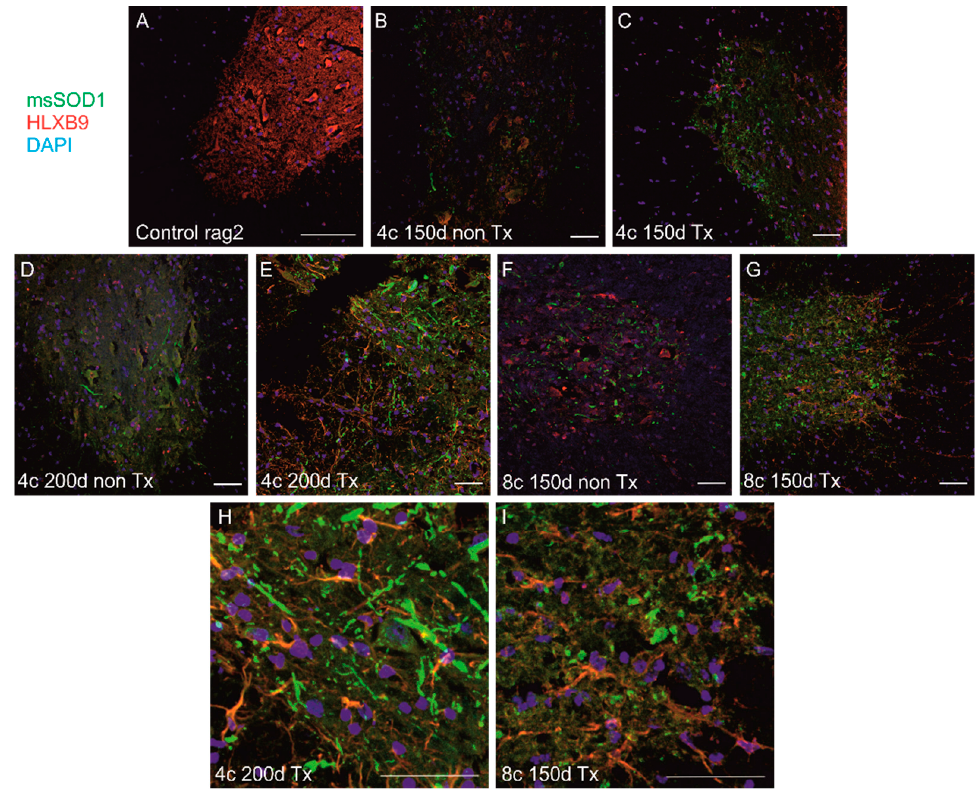
Figure 6. Immunohistochemical analysis of spinal cords from mice transplanted with Q-Cells ® and nontransplanted mice. There was no visible difference in spinal msSOD1 aggregation (green) was observed between: nontransplanted ( B ) and transplanted ( C ) 4-copy mice at 150 days; nontransplanted ( D ) and transplanted ( E , H ) 4-copy mice at 200 days; nontransplanted ( F ) and transplanted ( G , I ) 8-copy mice at 150 days. ( H , I ) represent cropped images of ( E , G ) respectively. Nontransplanted hSOD1(-) Rag2 mice spinal cord is shown as a control ( A ). HLXB9 was used for neuronal staining (red) and nuclei were counterstained with DAPI (blue). Scale 100 μ m. Sample size within the Rag2 control group: n = 3; SOD1/rag2 nontransplanted 4-copy group at 150 days: n = 7; SOD1/rag2 transplanted 4-copy group at 150 days: n = 5; SOD1/rag2 nontransplanted 4-copy group at 200 days: n = 3; SOD1/rag2 transplanted 4-copy group at 200 days: n = 6; SOD1/rag2 nontransplanted 4-copy terminal group: n = 5; SOD1/rag2 nontransplanted 8-copy terminal group: n = 4; SOD1/rag2 transplanted 8-copy terminal group: n = 4.